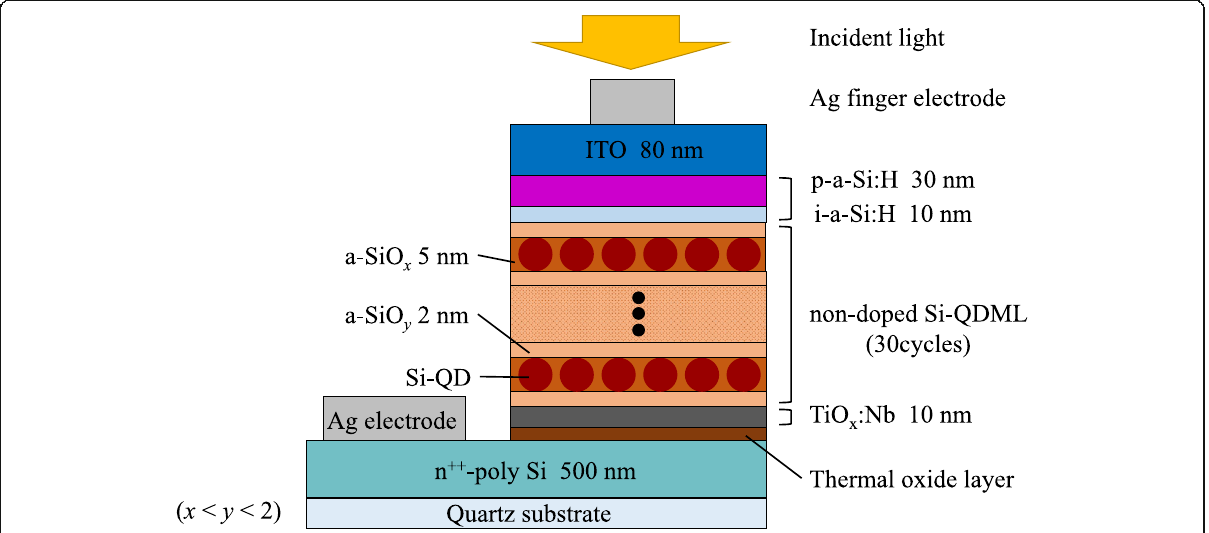
Fig. 1 Schematic cross-sectional diagram of Si-QD solar cell structure, not in scale. A part of the samples was removed the thermal oxide layer